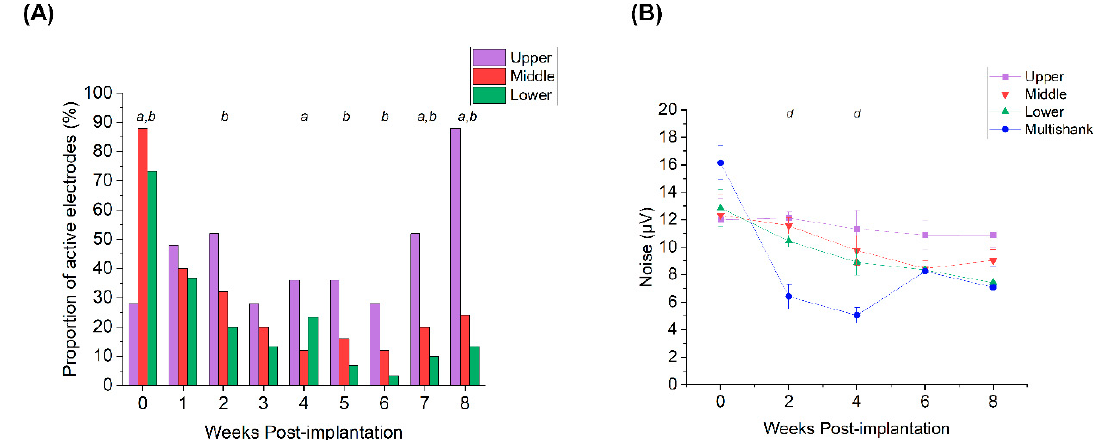
Figure 5. Depth-dependent electrophysiological measures. ( A ) Proportion of active microelectrodes for upper (violet), middle (red), and lower (green) microelectrodes located in the SS arrays. The annotation a denotes significant differences between upper and middle groups, b denotes significant differences between upper and lower groups, and c denotes significant differences between middle and lower groups, respectively (test of proportions z -test, p < 0.05). ( B ) Noise levels for the microelectrodes at different depths. The annotation d indicates significant differences during Week 2 and Week 4 between upper third and multi-shank microelectrodes. Data presented as the mean ± SEM.